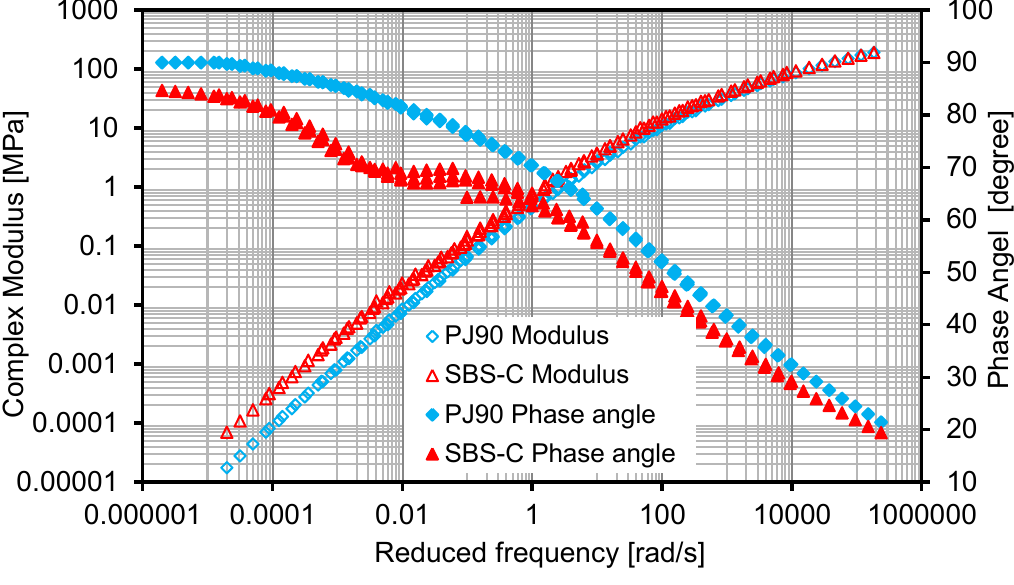
Figure 10. Master curves of two kinds of bituminous